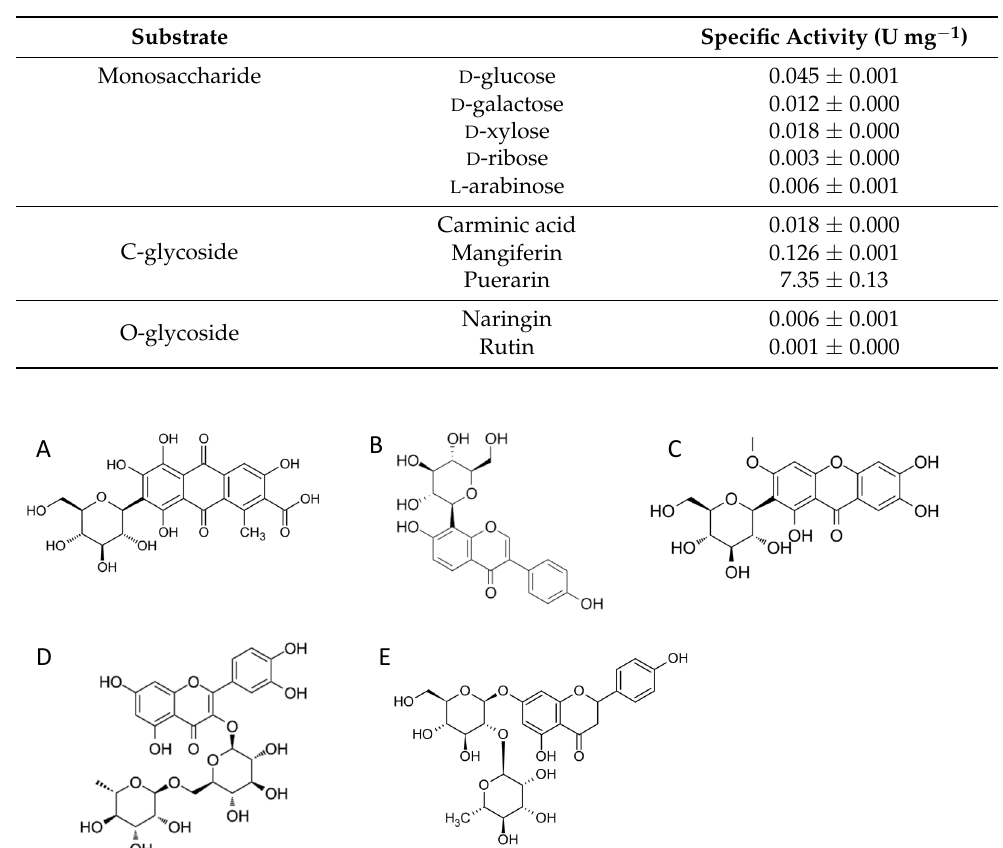
Table 1. Activities of Sc POx for different monosaccharides at final concentrations of 200 mM and various C- and O-glycosides at final concentrations of 0.2 mM, measured with DCIP as electron acceptor at 30 ◦ C in 50 mM potassium phosphate buffer, pH = 6.5 in triplicates.